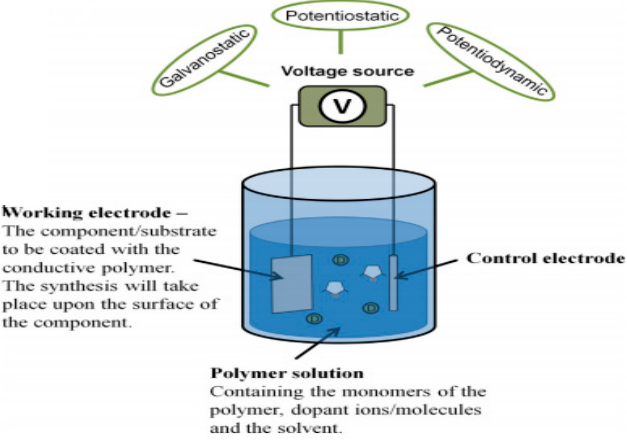
Figure 9. A schematic of the electrochemical synthesis set-up. Reprinted with permission from Balint et al. [114] Creative Commons